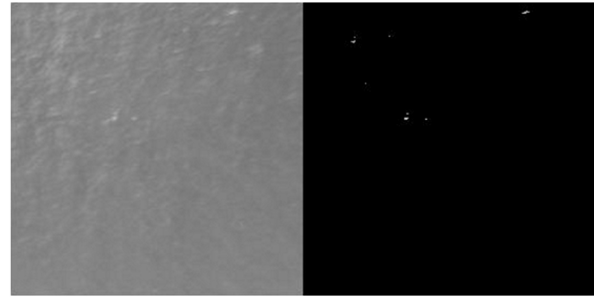
Fig. 7. Image processed for white capping measurement